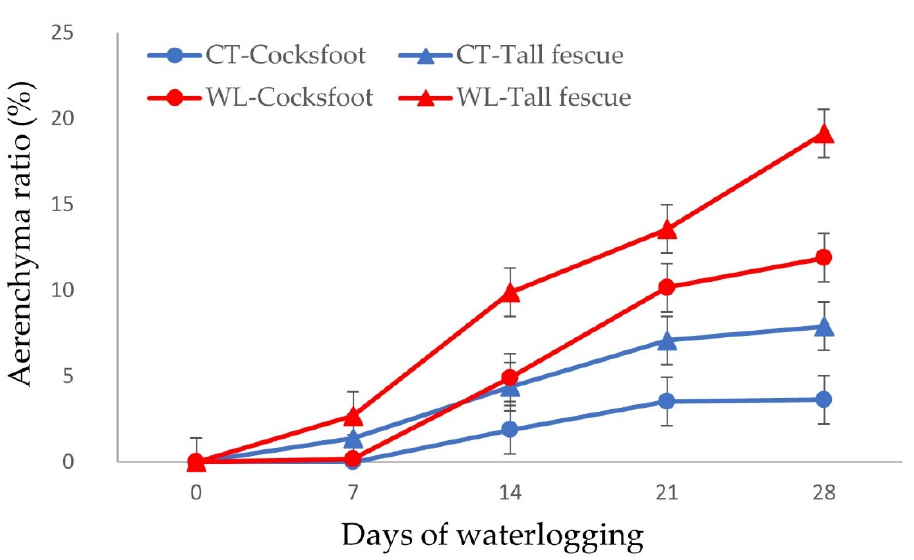
Figure 4. Formation of aerenchyma in the adventitious roots of cocksfoot and tall fescue at different stages of treatments under both control (CT) and waterlogging (WL) conditions. Values given are least squares means of four replicates and error bars indicate 95% confidence intervals of the least squares means. Table 2. Morphometric, biomass and chlorophyll measurements of tall fescue and cocksfoot in response to waterlogging. Values presented are least squares means of 4